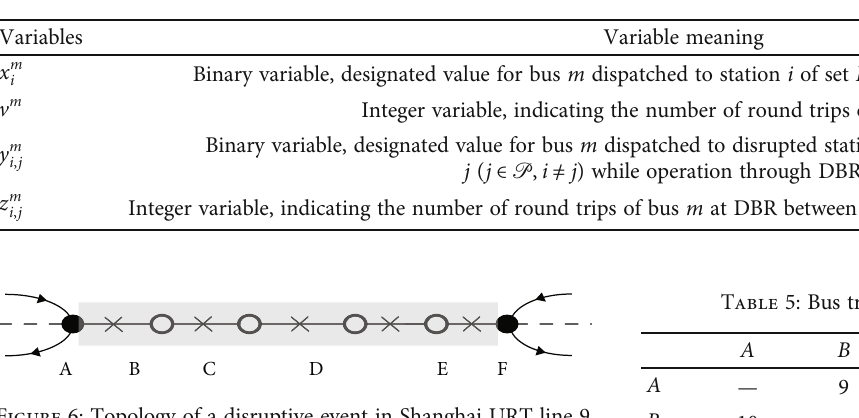
Table 3: Variables in the model.